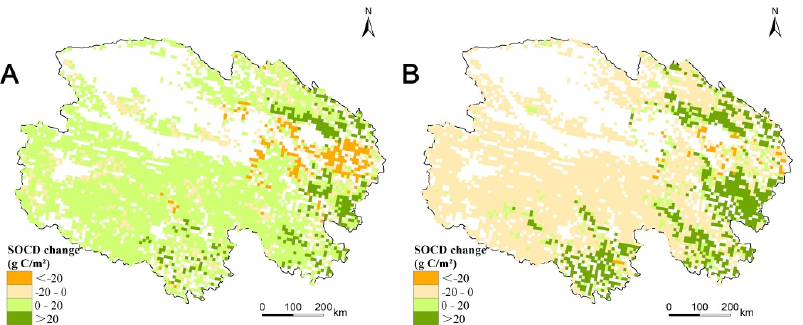
Figure 5. Temporal ( A ) and spatial ( B ) dynamics of soil organic carbon density (SOCD) for the upper 100 cm and a map showing this trend ( C ) in the Qinghai grasslands from 1979 to 2018. As shown in Figure 6, from 1979 to 2000, SOCD notably increased in parts of southern and eastern Qinghai, while SOCD notably decreased in the area between southeastern and northeastern Qinghai. SOCD showed a slight increased trend in cen ‐ tral and western Qinghai. From 2001 to 2018, VCD notably increased in the southern and eastern Qinghai.